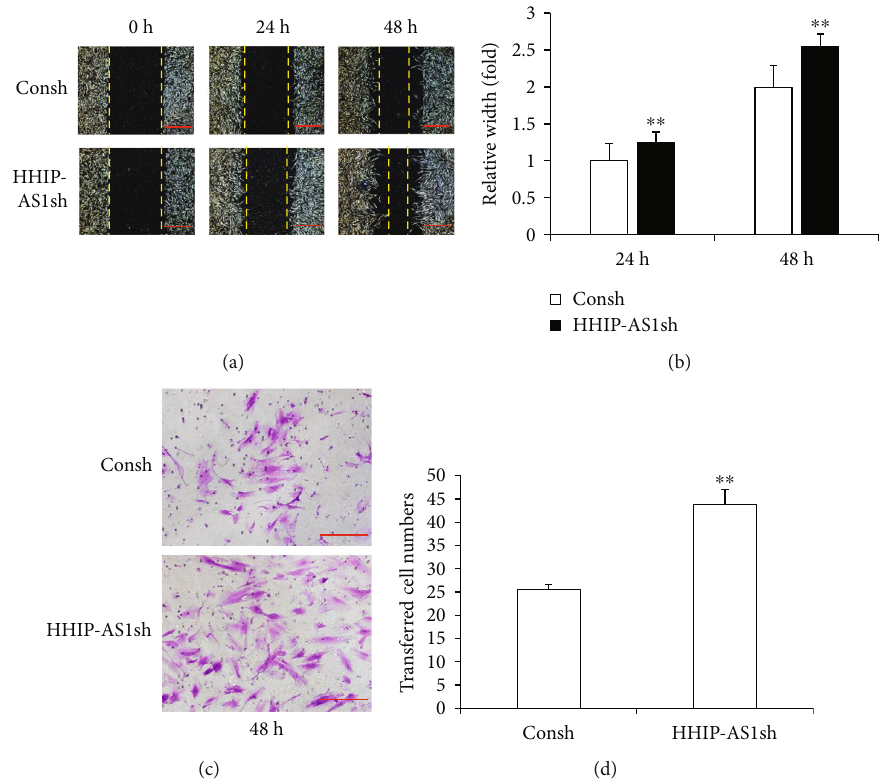
Figure 3: HHIP-AS1 knockdown promoted the migration and chemotaxis abilities of PDLSCs. The results of the (a) scratch migration assay and (b) quantitative analysis at 24 and 48h (scale bars: 1mm). The results of the (c) transwell chemotaxis assay and (d) quantitative analysis at 48 h (scale bars: 200 μ m). Student ’ s t -test was performed to determine statistical signi fi cance. All error bars represent the SD ( n = 9 ). ∗∗ P ≤ 0 : 01